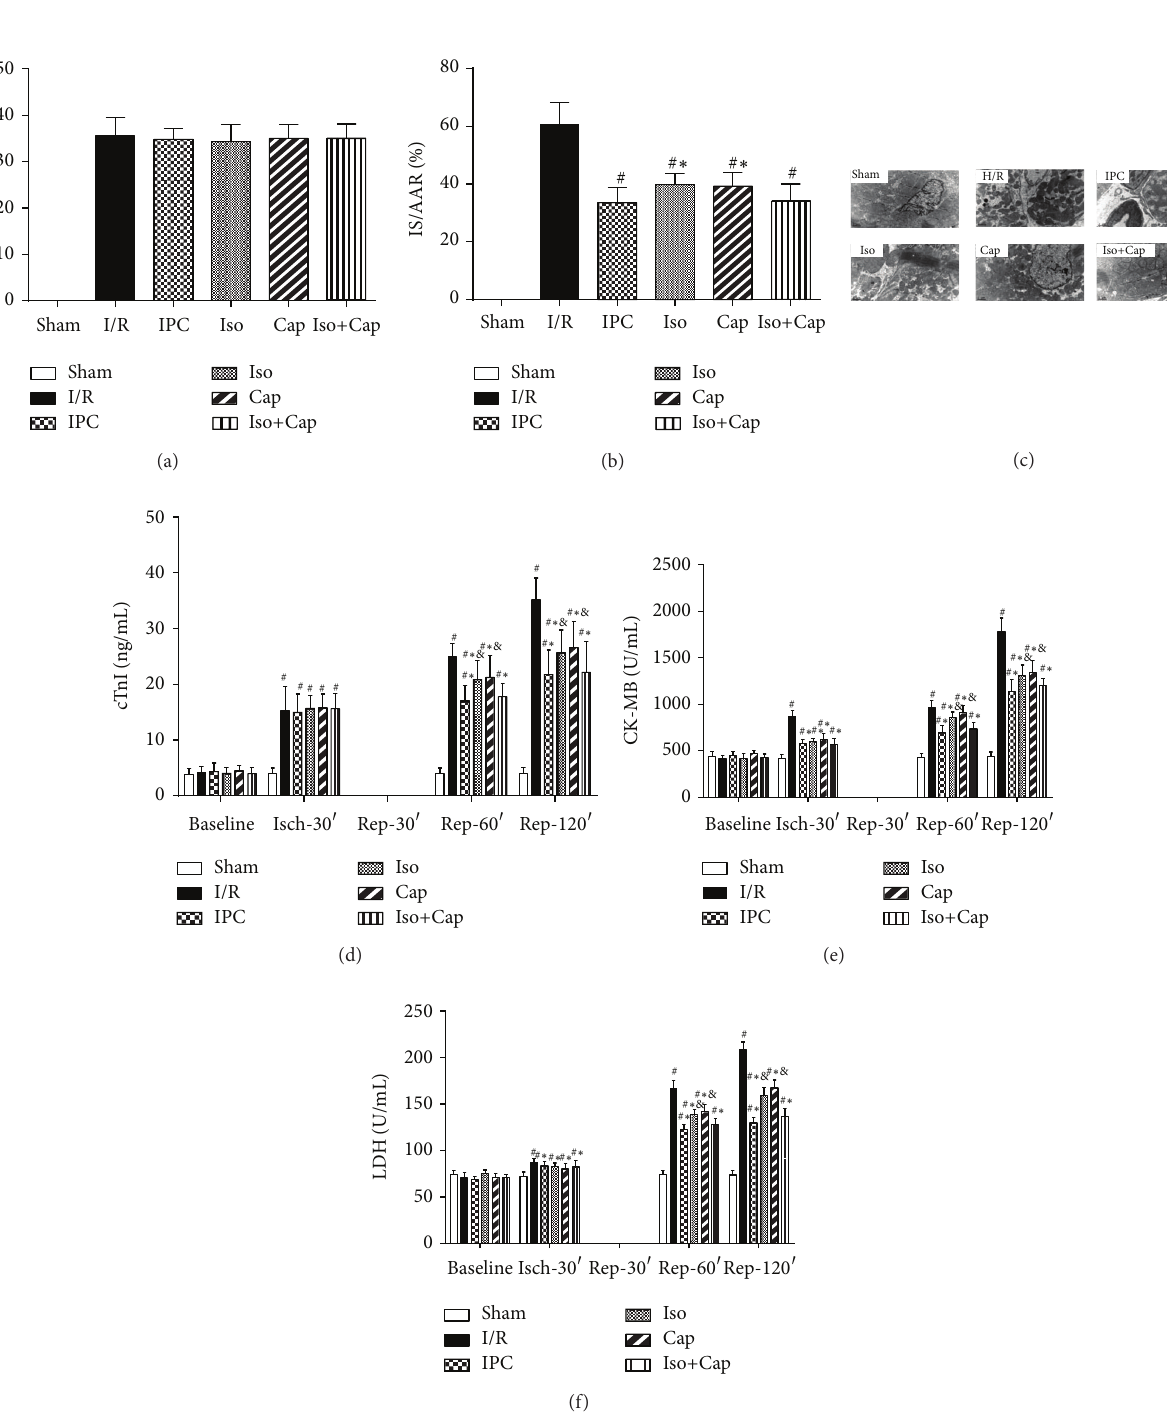
Figure 3: Isoflurane (Iso)and captopril (Cap) reduced postischemic myocardial injury, ameliorated myocardial inflammation, and attenuated cardiac ultrastructural alterations in rabbits. (a) Ratio of area at risk (AAR) to left ventricular (LV), (b) percentage of infarct size (IS) expressed as a percentage of AAR, (c) representative images of electron micrograph of rabbit hearts, (d) plasma cTnI, (e) plasma CK-MB, and (f) lactate dehydrogenase (LDH). Sham: sham operated control; I/R: rabbits subjected to myocardial ischemia reperfusion (MI/R); Cap: rabbits treated with captopril (25 mg/kg given intravenously 24 h) prior to inducing MI/R; Iso: rabbits received isoflurane preconditioning (15min 1.1% end tidal isoflurane followed by a 15min washout period before inducing MI/R); Iso+Cap: rabbits received captopril in combination with Iso. Data are shown as means ± SD, with 𝑛 = 8 animals per group. # 𝑃 < 0.05 or 𝑃 < 0.01 versus I/R, ∗ 𝑃 < 0.05 versus IPC, and & 𝑃 < 0.05 versus